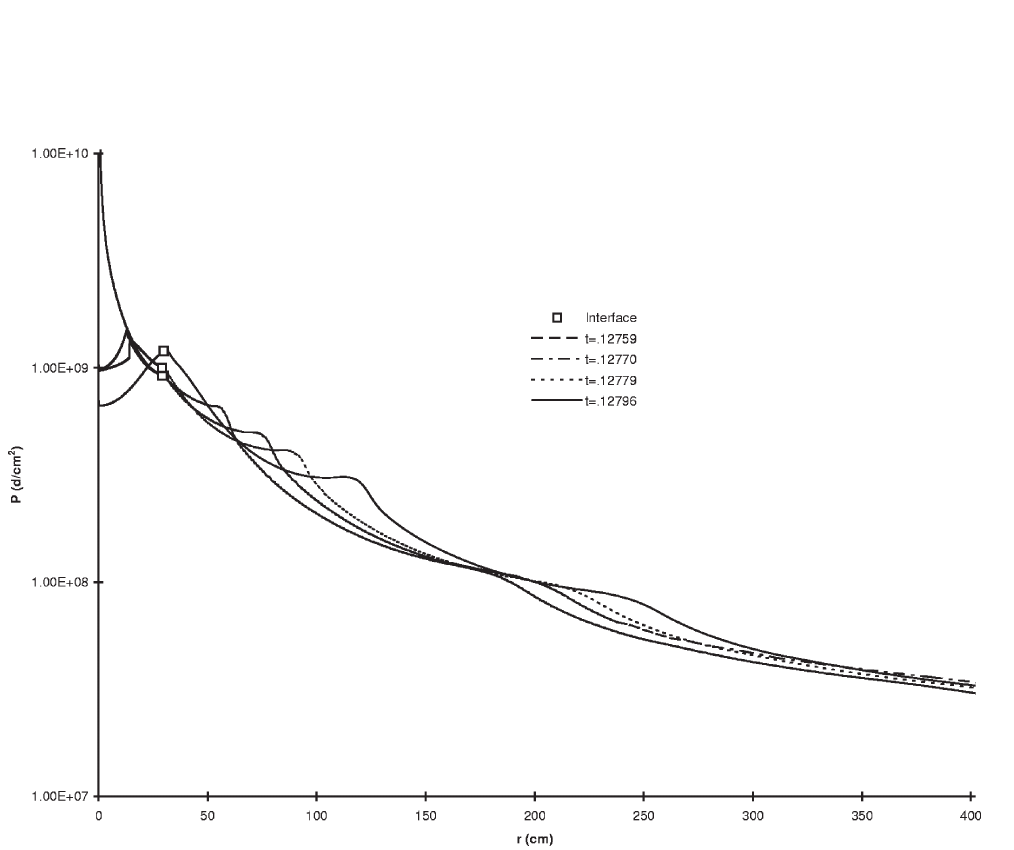
Fig. 5. Comparison of solutions during the shock interaction sub-phase.